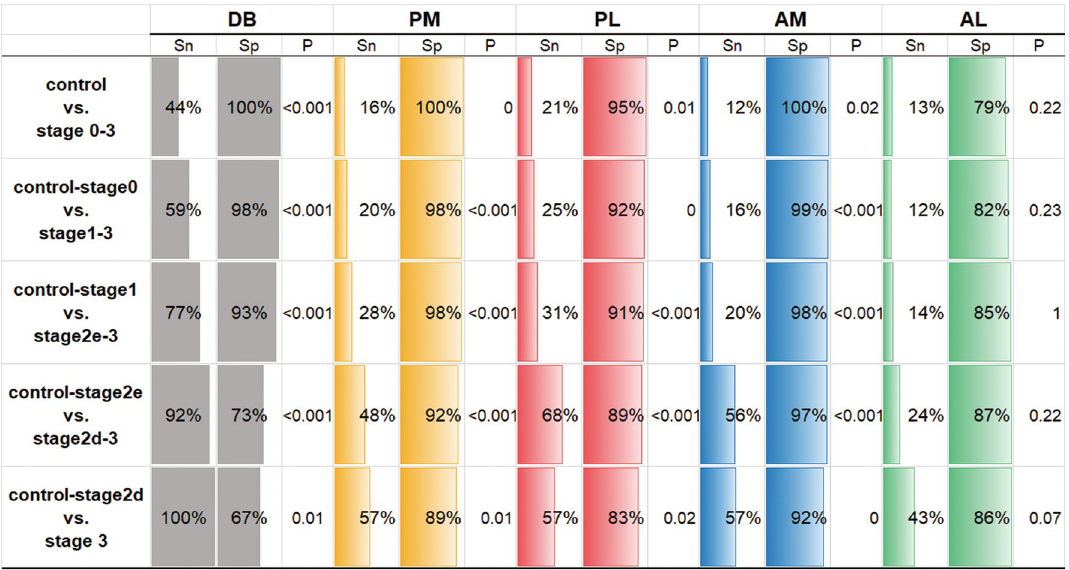
Figure 4. Sensitivity and specificity of dermal back-flow and defects in lymphatic groups for the diagnosis of lymphedema. Except for the anterolateral group, dermal back-flow (DB) and defects in the three lymphatic groups (anterolateral, posteromedial, and posterolateral) showed a statistically significant difference in distinguishing all stages. Although DB had low sensitivity but high specificity to detect lymphedema (control vs. International Society of Lymphology [ISL] stages 0 ‒ 3), it had high sensitivity but low specificity to judge severity (control–stage 2e vs. stage 2d ‒ 3, and control–stage 2d vs. stage 3). Although each of three lymphatic group defects had low sensitivity for diagnosis and judgment of severity, they retained a high specificity for all stages. Sn sensitivity, Sp